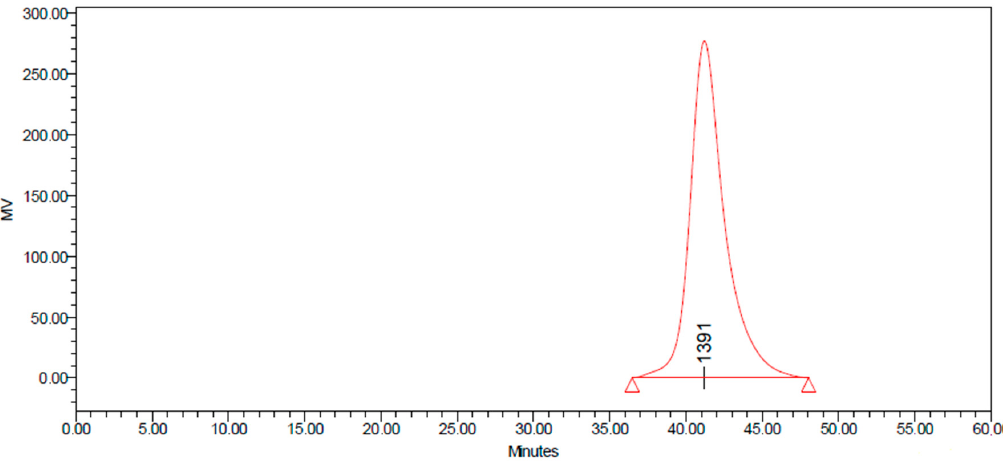
Figure 7. FT-IR spectrum of the product (red line) and the substrates 1,1,1,3,5,5,5-heptamethyltrisiloxane (yellow line) and allyl polyether (blue line).